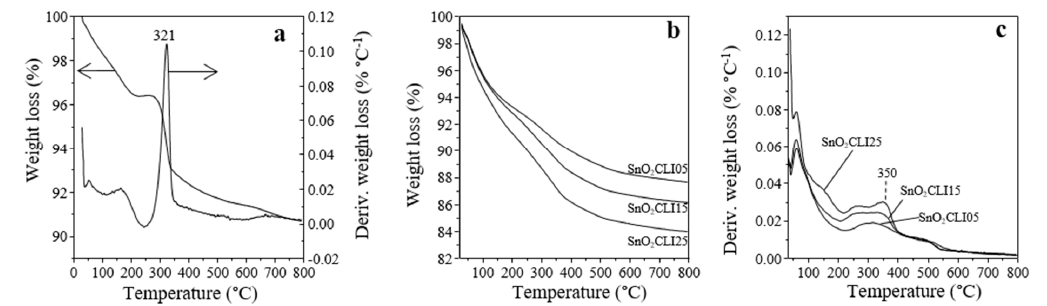
Figure 2. TG/DTG (weight loss/differential of weight loss) curve of non-calcined ( a ) SnO 2, ( b ) TG curves of SnO 2 -containing clinoptilolite, and ( c ) DTG curves of SnO 2 -containing clinoptilolite.